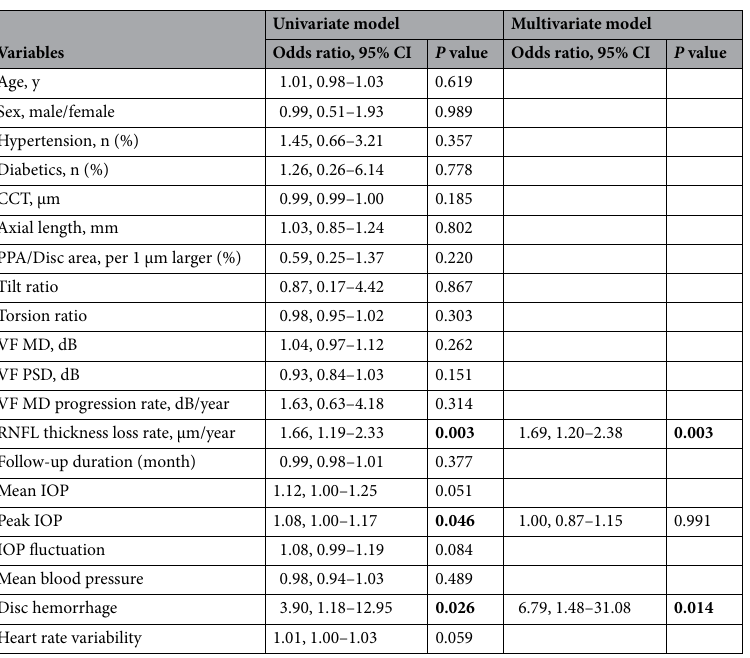
Table 3. Factors associated with the Beck Anxiety Inventory (BAI) scores in patients with glaucoma. Logistic Regression Analysis of BAI score. CI, confidence interval; CCT, central corneal thickness; PPA, peripapillary atrophy; VF, visual field; MD, mean deviation; PSD, pattern standard deviation; RNFL, retinal nerve fiber layer; IOP, intraocular pressure. Variables with p < 0.05 were included in the multivariate analysis. Statistically significant values are shown in